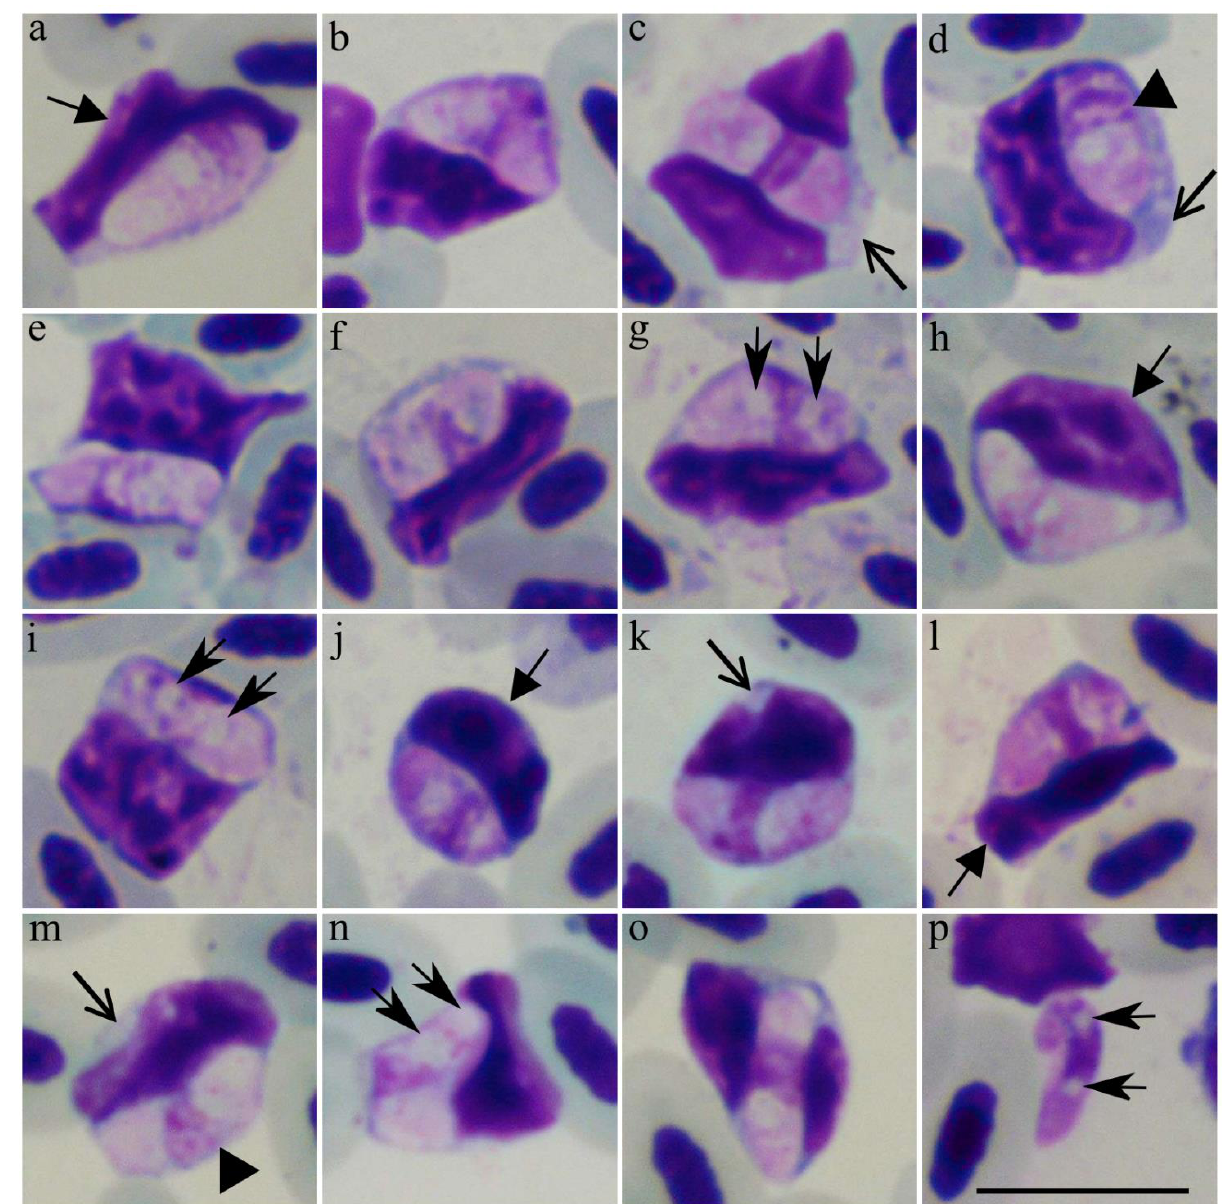
Figure 2. Intracellular ( a – o ) and a free ( p ) sporozoites of Lankesterella bivacuolata n. sp. ( 18S rRNA lineage LanTurd1) from a Eurasian blackbird ( Turdus merula ). Parasites develop in mononuclear leukocytes, which can be readily distinguished from other leukocytes due to basophilic staining of the cell cytoplasm ( c , d , l , m ). Note that sporozoites markedly deform the host cell nuclei, which were frequently distorted and assumed elongated shapes ( a , f , g , k , m ). Two vacuole-like structures were closely appressed to the parasite nuclei ( g , i , n , p ), which are elongate and occupy the entire width of the sporozoites ( d , m ). Triangle arrowhead ( ), parasite nucleus. Short-barbed arrow ( ), vacuole-like structures. Short triangle arrow ( ), host cell nuclei. Simple wide arrow ( ), host cell cytoplasm. Scale bar: 10 µm. Methanol fixed and Giemsa-stained blood films. Table 2. Morphometry of sporozoites of Lankesterella bivacuolata n. sp. ( 18S rRNA lineage LanTurd1). All the measurements are given in micrometres.